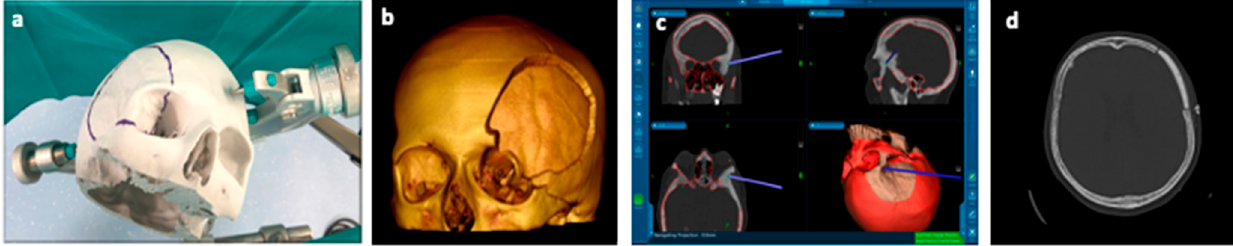
Figure 7. ( a ) Phantom model for virtual craniotomy; ( b ) 3D HR CT-scan of Phantom; ( c ) stealth navigation station; ( d ) post-operative axial CT-scan.